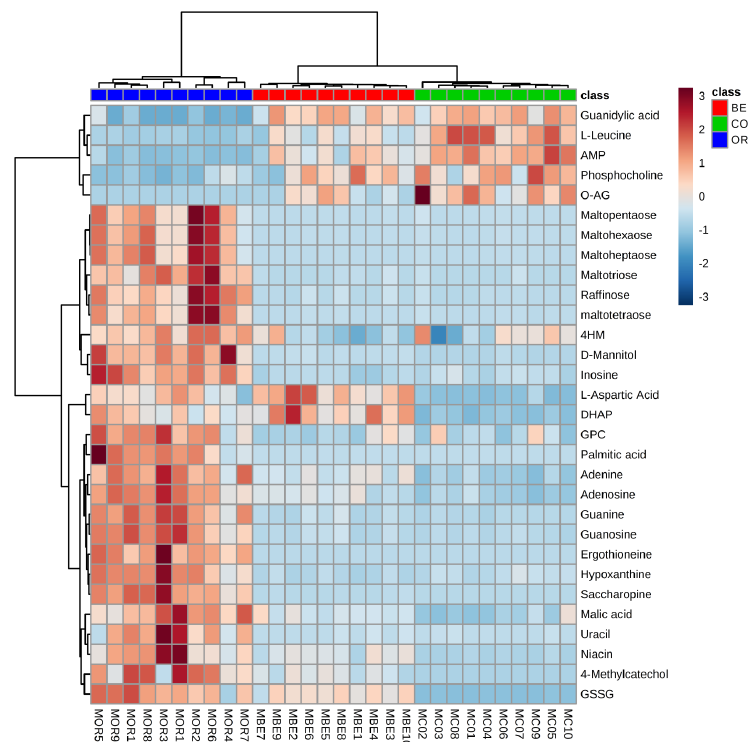
Figure 4. Venn diagram representing overlap between the two groups samples comparing all ion features found to be increased ( ↑ ) and decreased ( ↓ ) in O. unilateralis- infected mandible muscle